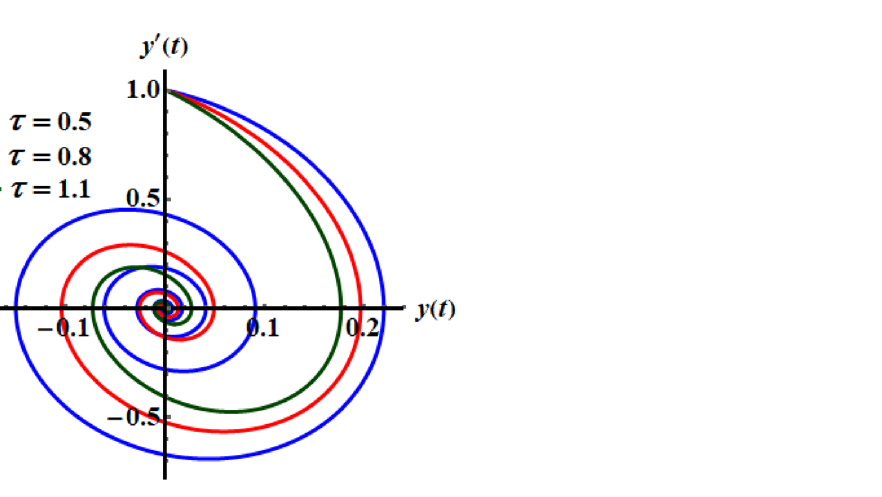
Figure 2. The phase plane curves of the represented curves of Fig. 1.